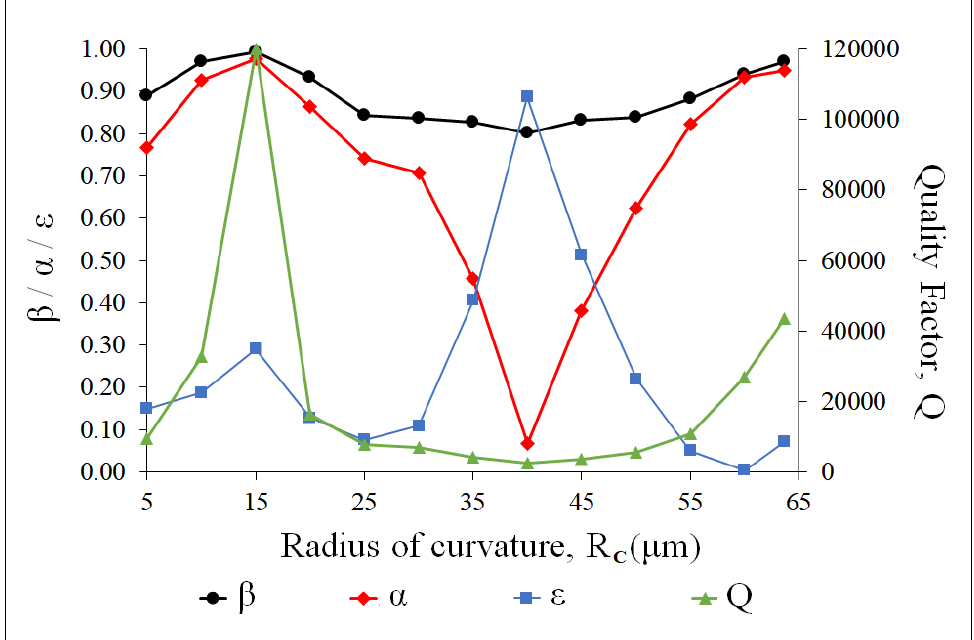
Figure 8. Optical parameters for a waveguide coupled with RCSS microresonator, TE mode, the total optical path length is 400 µ